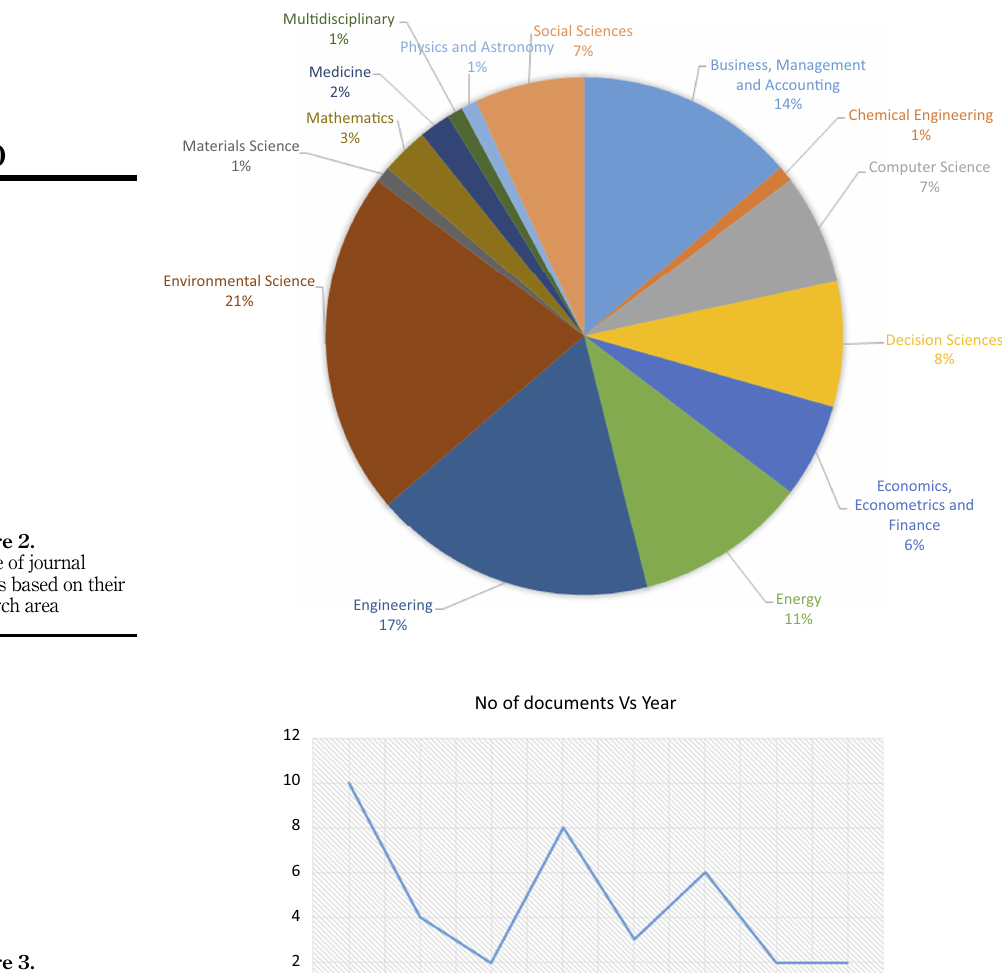
Figure 3. Number of